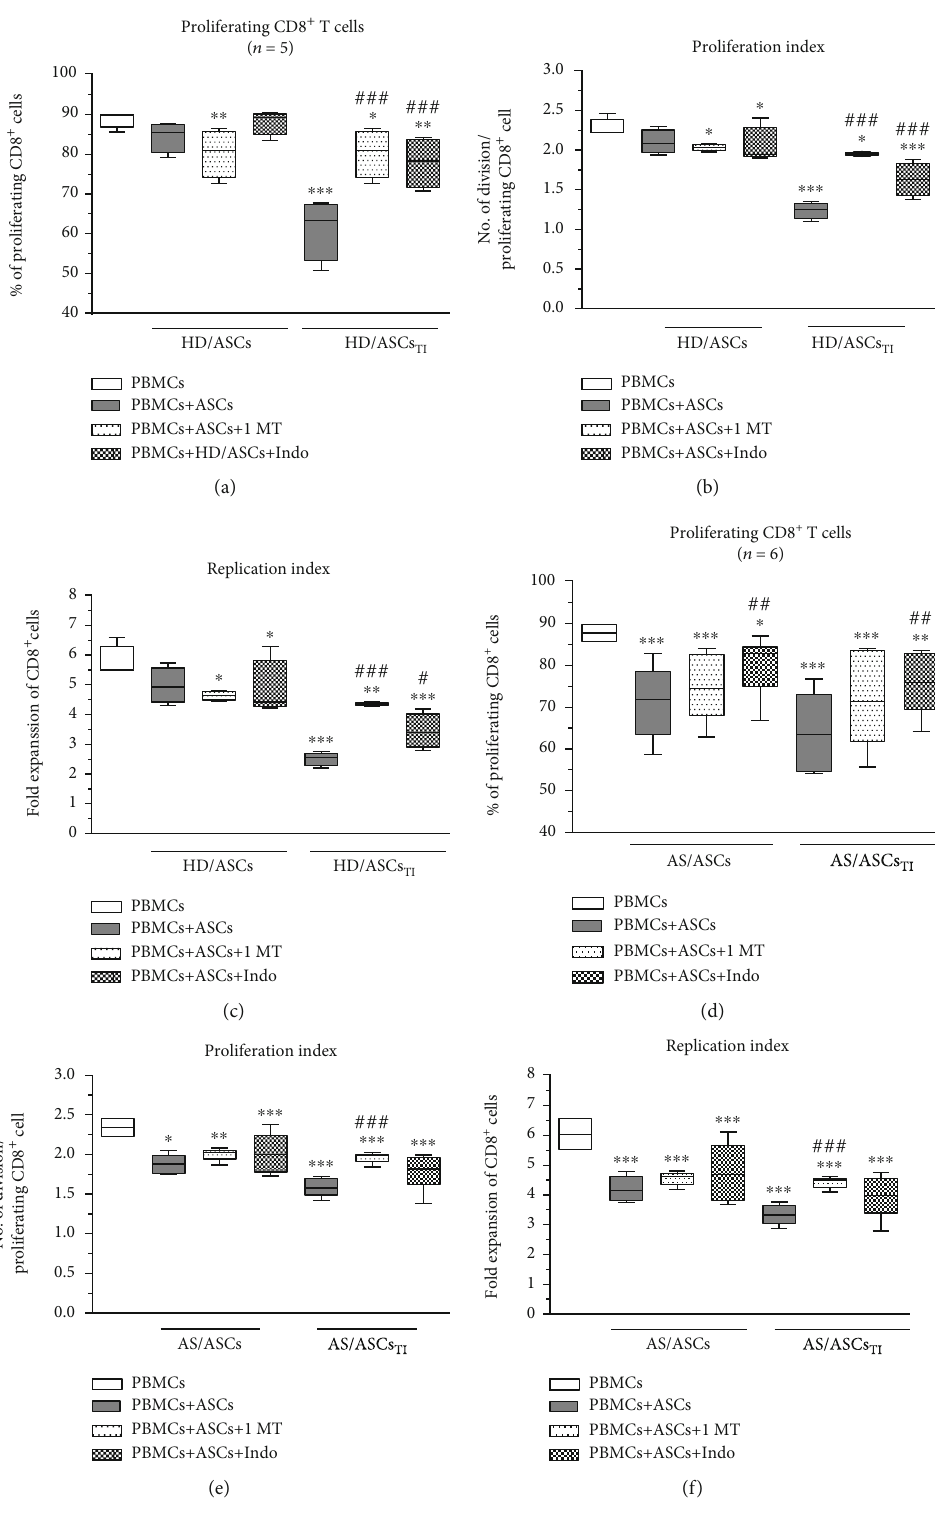
Figure 7: Selective inhibitors of kynurenines (1-MT) and PGE (indomethacin) synthesis counteract the inhibitory e ff ect of ASCs on the 2 proliferation of CD8 + T cells. Cell preparation, culture conditions, concentrations, and time of cell treatment with 1-MT and indomethacin (Indo) and other explanations as in Figure 6, except that CD8+ T cells were